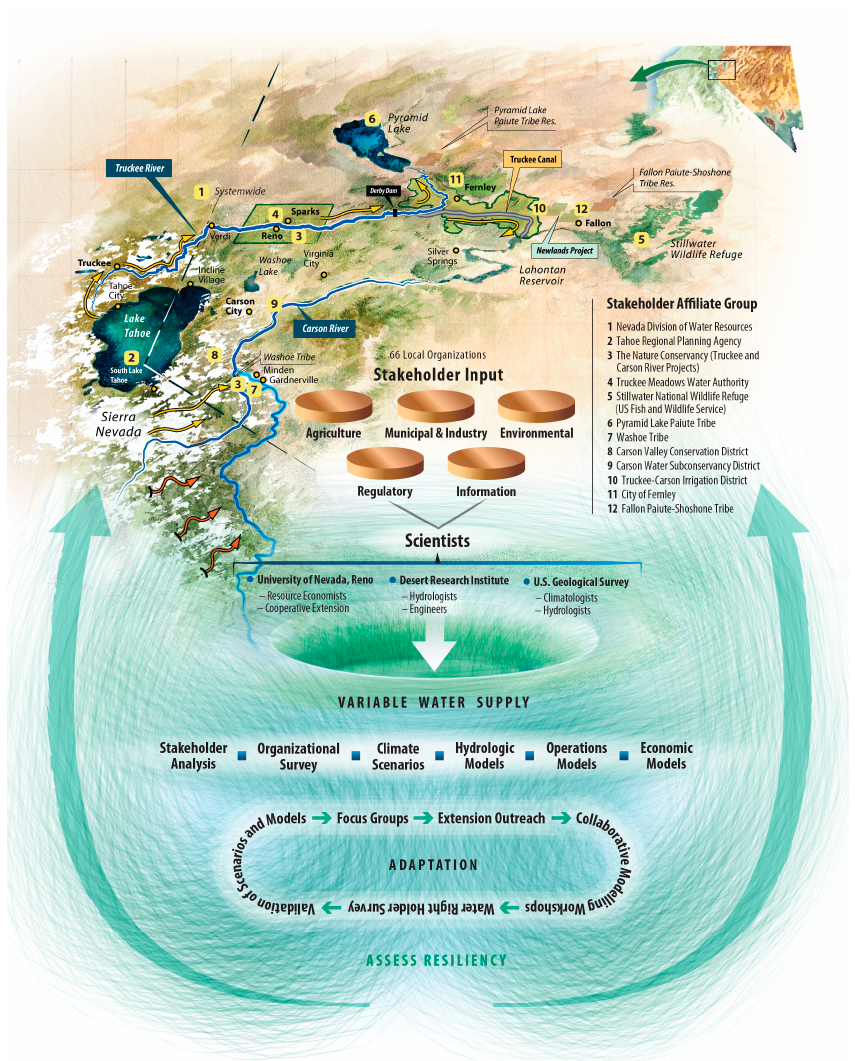
Figure 2. Collaborative Modeling Research Design, highlighting the location of Stakeholder Affiliate Group organizations [51].